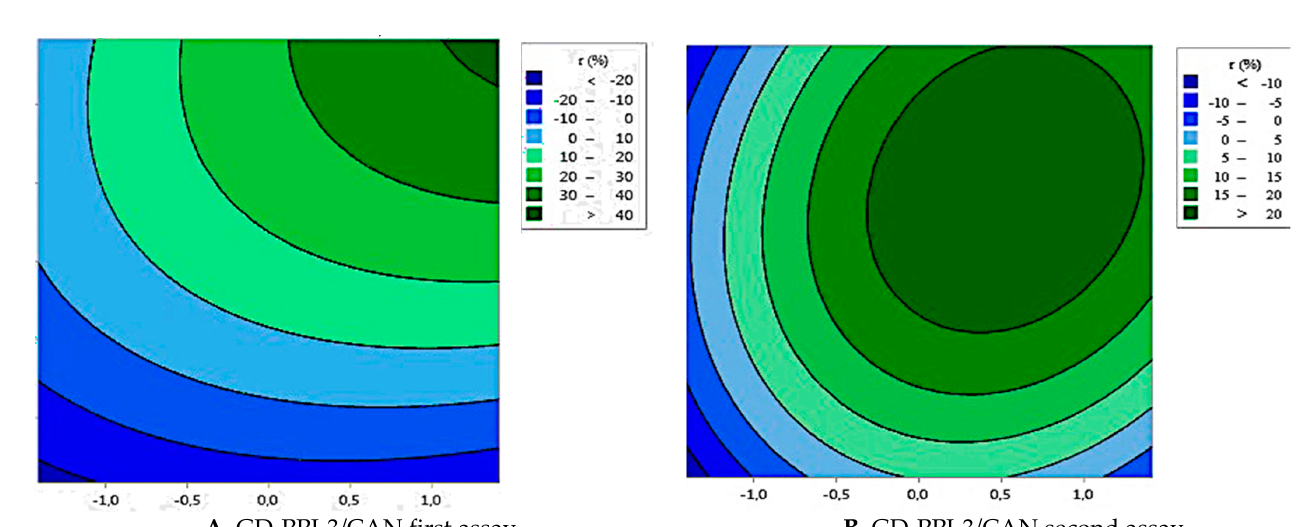
Figure 4. Contour plots showing the crossed effect of duration (D) and rate of stirring (R) on the retention rate (r) of cinnamon essential oil by GD-PPI-3 with the first sets of parameters ( A ) and the second one ( B ). Table 7. Factors and their levels selected for the second assay of Box–Behnken design (response surface methodology) for the GD-PPI-3/CAN EO encapsulation.